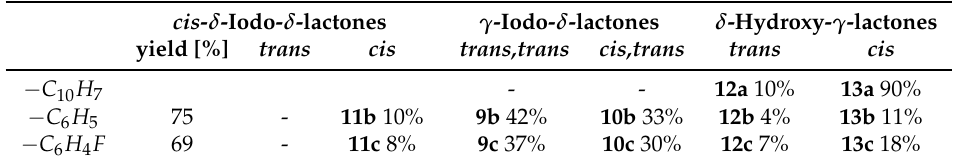
Figure 2. Mechanisms of chloro- and bromolactonization of γ , δ -unsaturated carboxylic acids with NCS and NBS. Table 2. The yields and products distribution from iodolactonization of unsaturated carboxylic acids 4a – c (according to